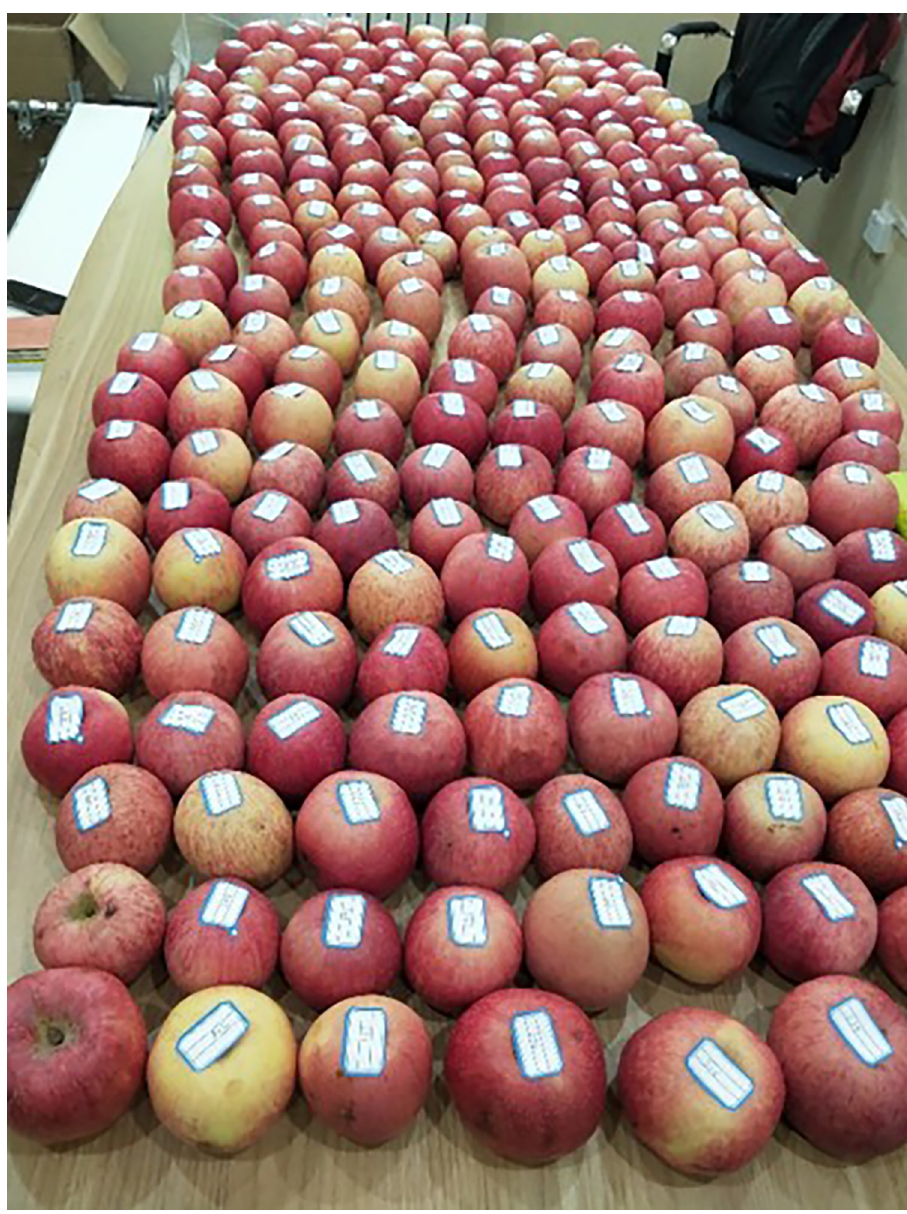
Fig 1. Red Fuji apple